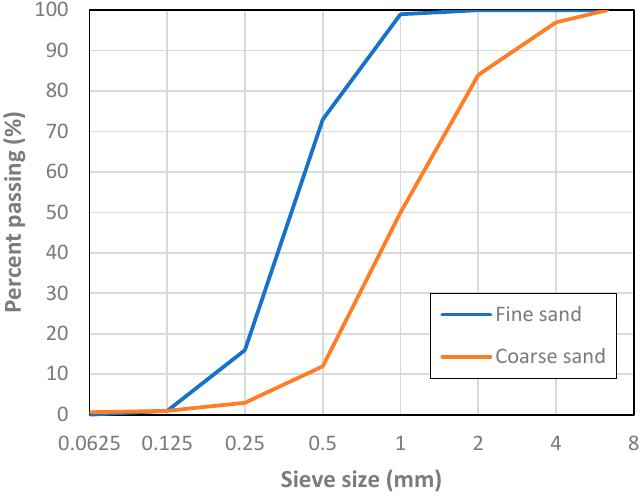
Figure 1. Aggregate particle size distribution.